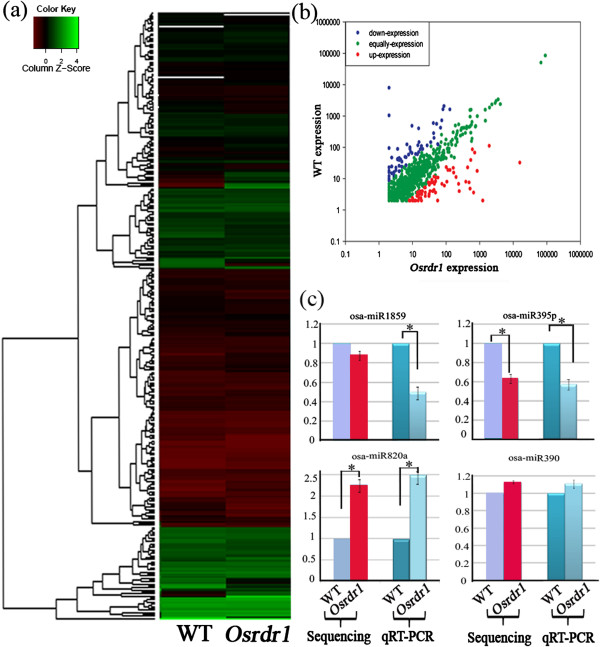
Effects of null mutation of OsRDR1 on abundances of miRNAs in rice. (a) Expression comparison of known miRNAs between Osrdr1 and WT. (b) Three patterns of expression changes of known miRNAs. The red and blue spots represent up and down-regulated in Osrdr1, respectively; the green spots represent no variation between Osrdr1 and WT. (c) qRT-PCR to verify variation of miRNA accumulation between Osrdr1 and WT. Statistical significance is marked by asterisks.